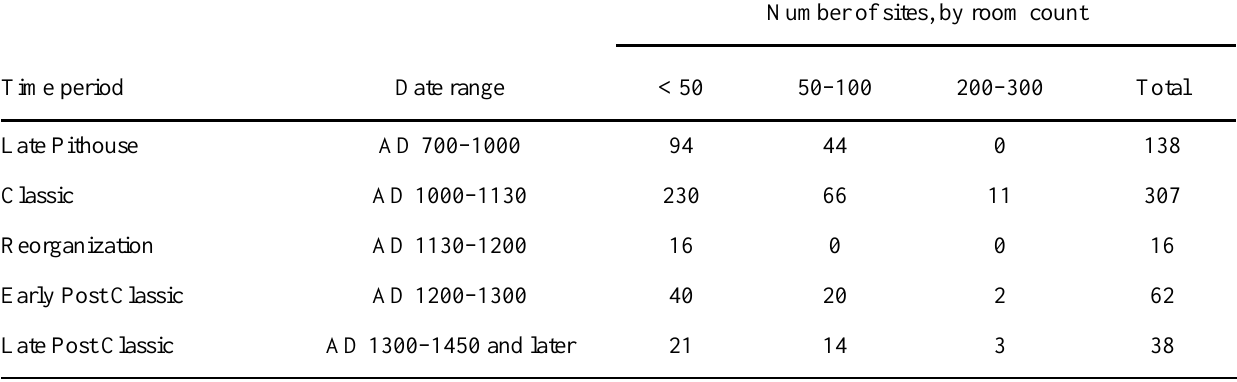
Number of sites, by room